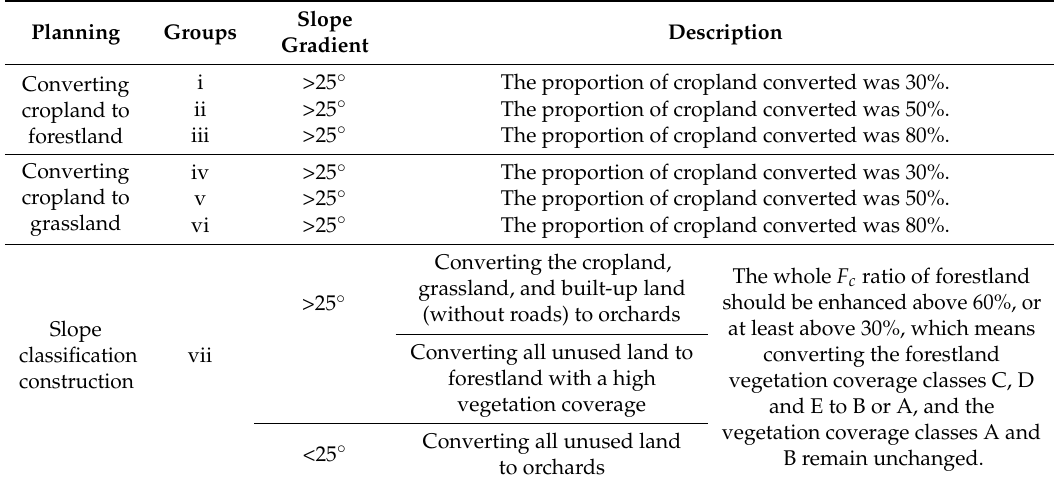
Table 1. The planning of the ESZR